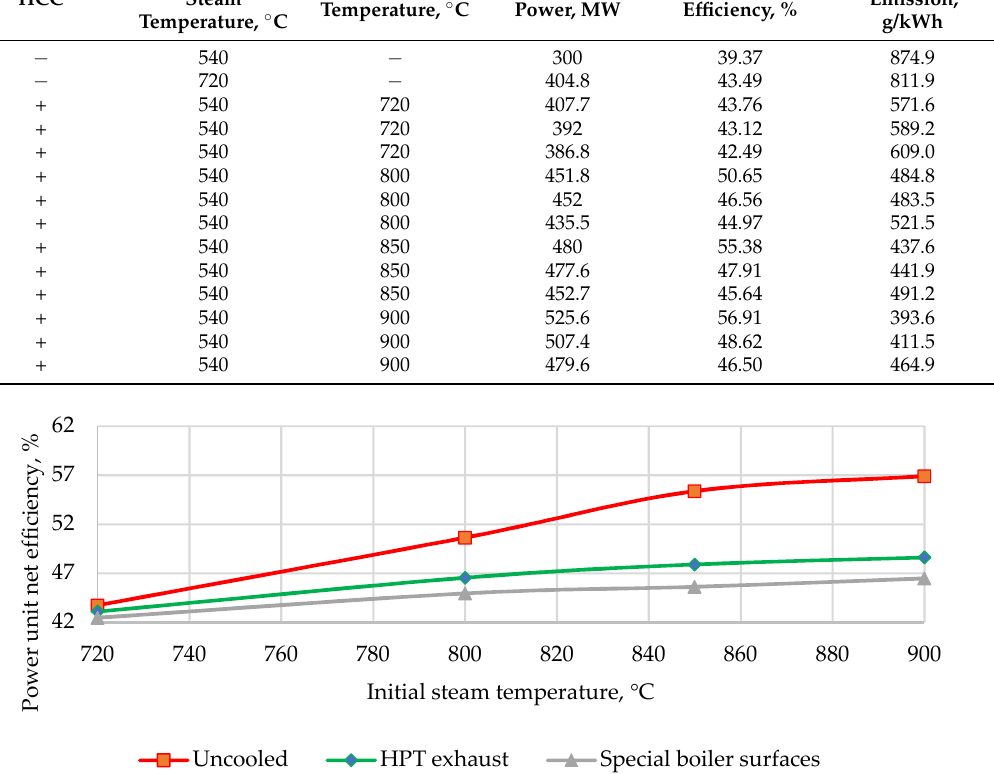
Figure 9. Power unit with HCC net efficiency with different cooling systems; HPT coolant is taken from the boiler header. Table 9. Comparison of different units’ parameters.